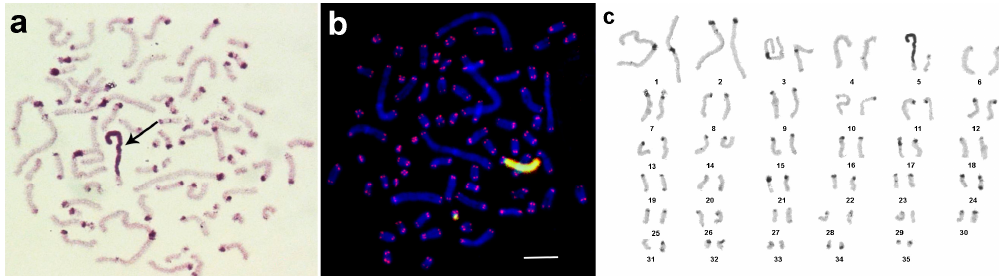
Figure 5. Metaphase plates of a female embryo of Phaenopharos khaoyaiensis . ( a ) C-banding: a large C-positive region is visible (arrow); ( b ) the C-positive region is highlighted by FISH (18S rDNA, green) and homologue chromosome is also stained. Scale bar indicates 5 μ m; ( c ) Female P. khaoyaiensis have 70 chromosome pairs, i.e., most likely a karyotype 34,XX.